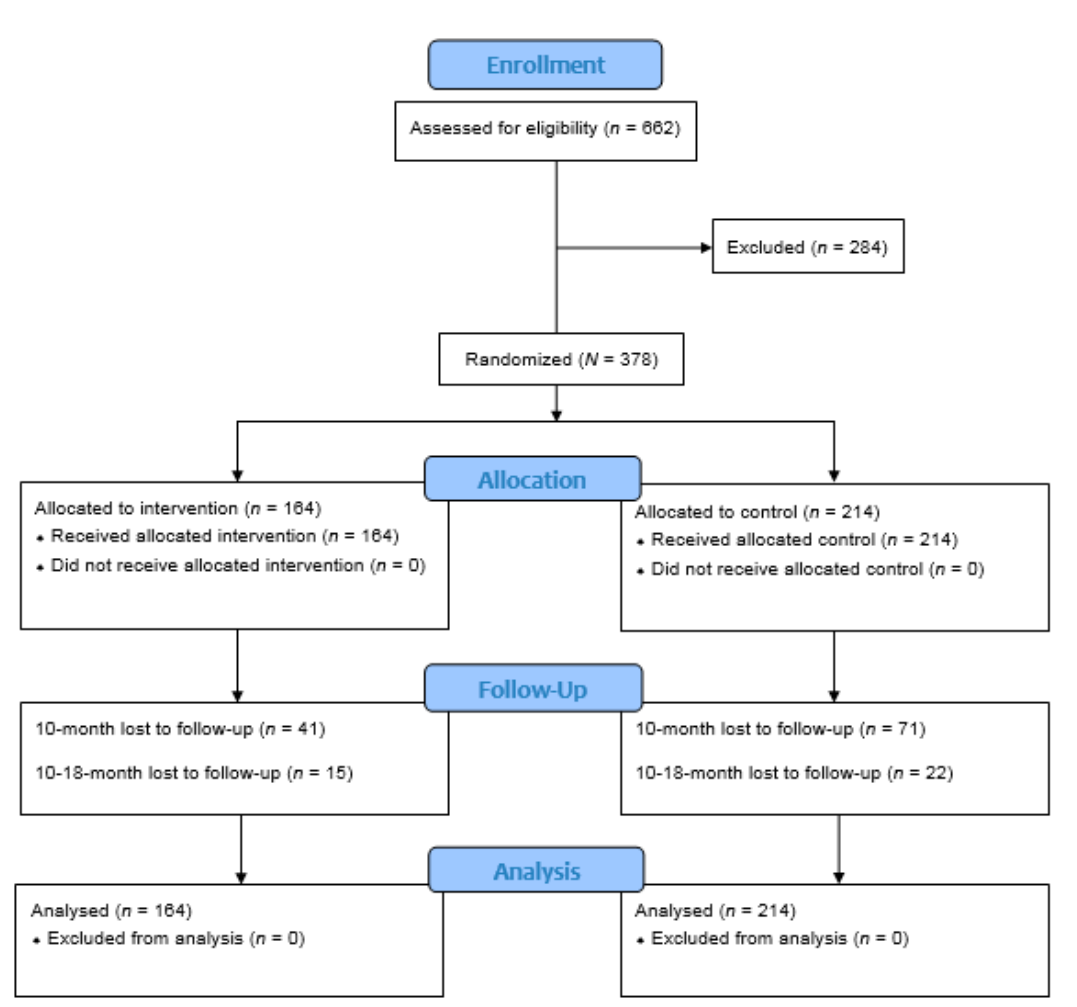
Figure 1. CONSORT 2010 Flow Diagram for SCOPE.